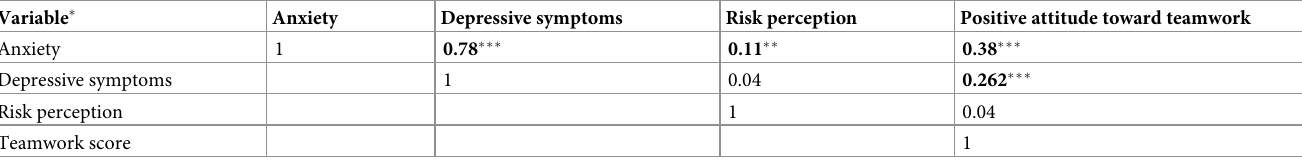
Table 6. Partial correlations showing the associations between the assessment tools used in this study. Variable �